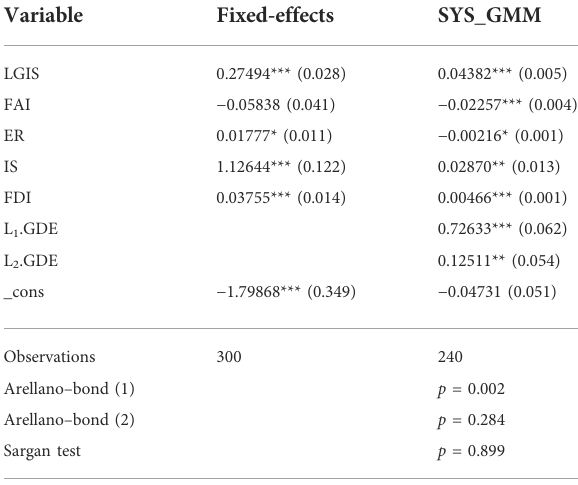
TABLE 5 Summary of the results for the dynamic panel system GMM model.